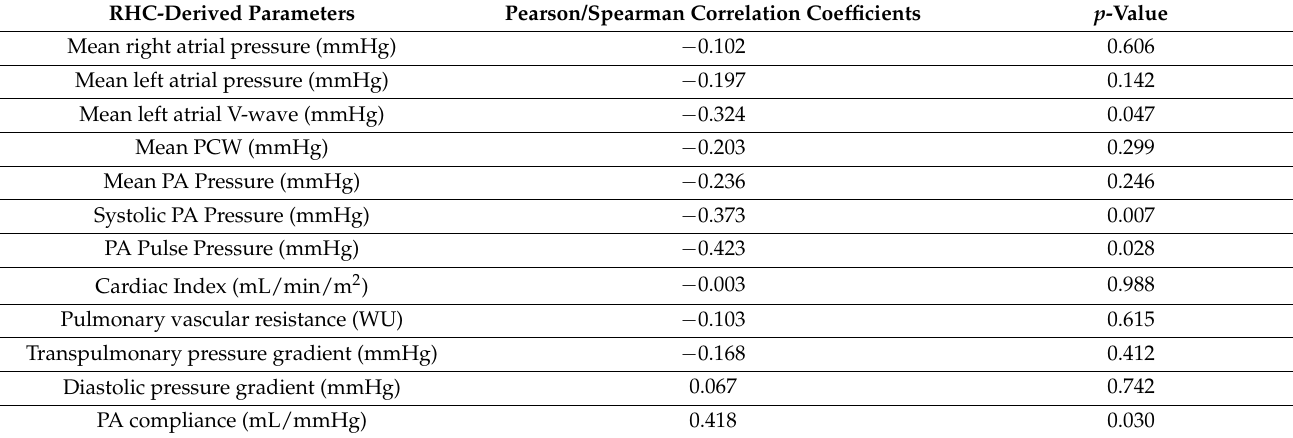
Table 2. Linear correlation analysis between TAPSE/PASP ratio and RHC-derived